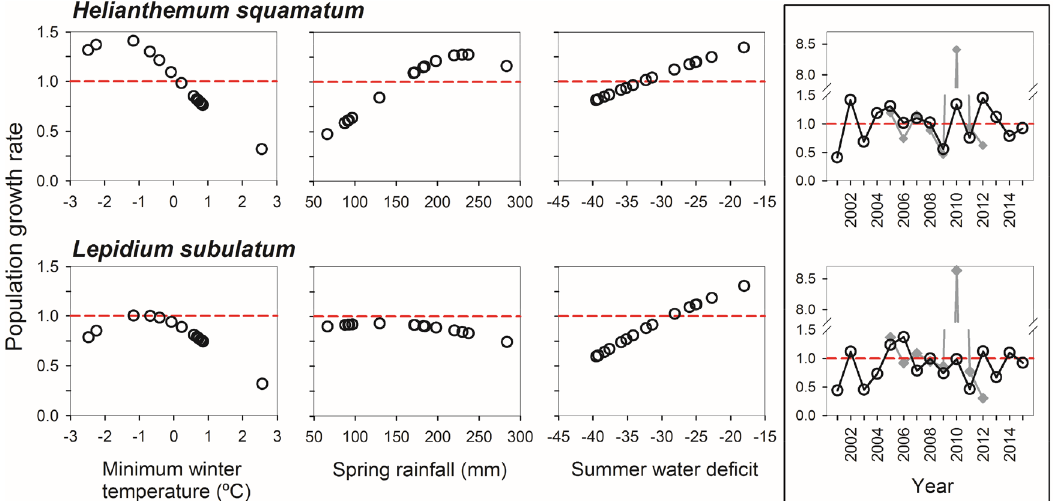
Figure 2. Variation in population growth rate (lambda) with climatic variables (minimum winter temperature, spring rainfall and summer water balance) for Helianthemum squamatum and Lepidium subulatum . Lambdas were obtained from the Integral Projection Model built for each species separately, adjusting it with the observed values of climatic variables from 2001 to 2015. Models were adjusted for block A and intra- and interspecific covers of 30%; results for block B were similar (see Supplementary Fig. S1). Right hand panels represent population growth rate per year combining the three climatic variables. Note that the highest value of simulated lambda (black line and open symbols) corresponded to 2012 in H. squamatum and 2006 in L. subulatum , whereas the highest increase in observed population growth rate (grey lines and filled symbols) occurred in 2010 and was much higher than that adjusted by the model.